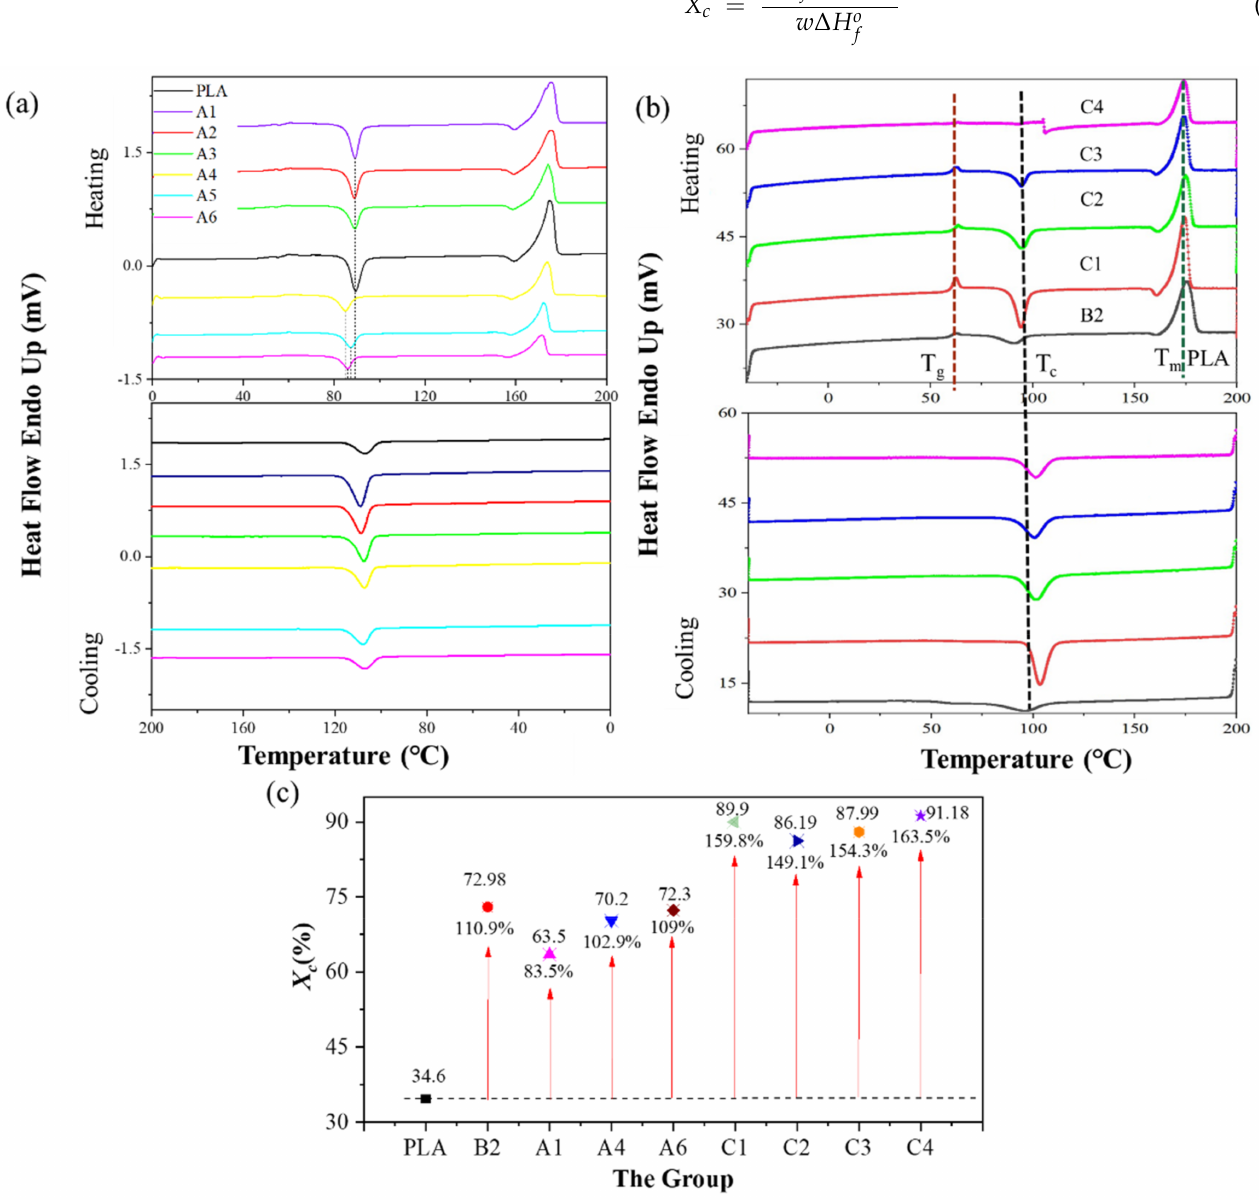
Figure 4. The thermal behavior of the polymers: ( a ) the DSC curves of group A, ( b ) the DSC curves of group C, and ( c ) X c